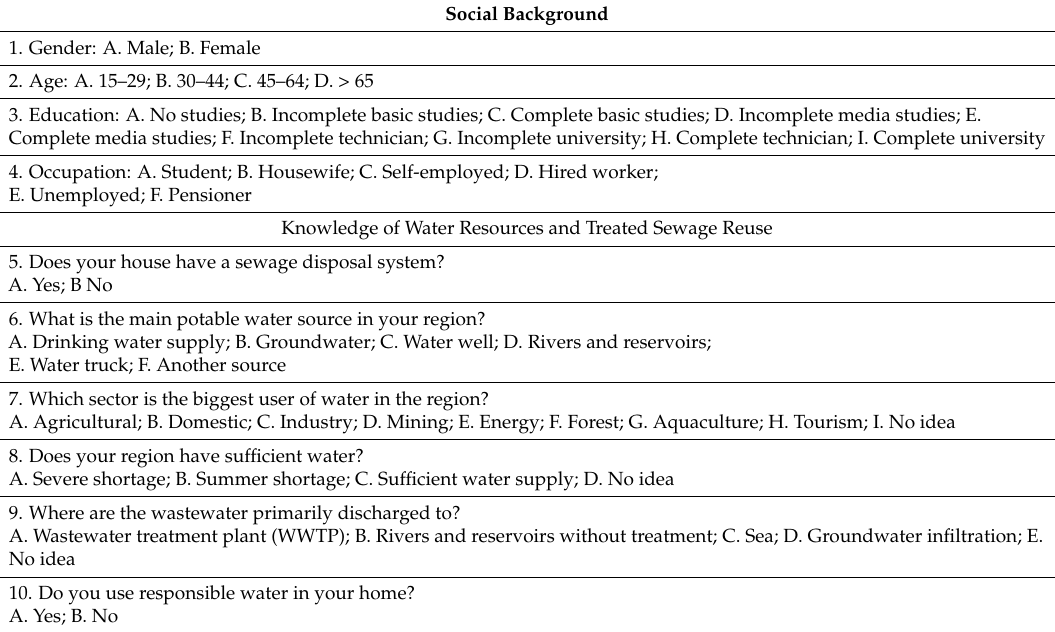
Table 3. Questionnaire applied to the group